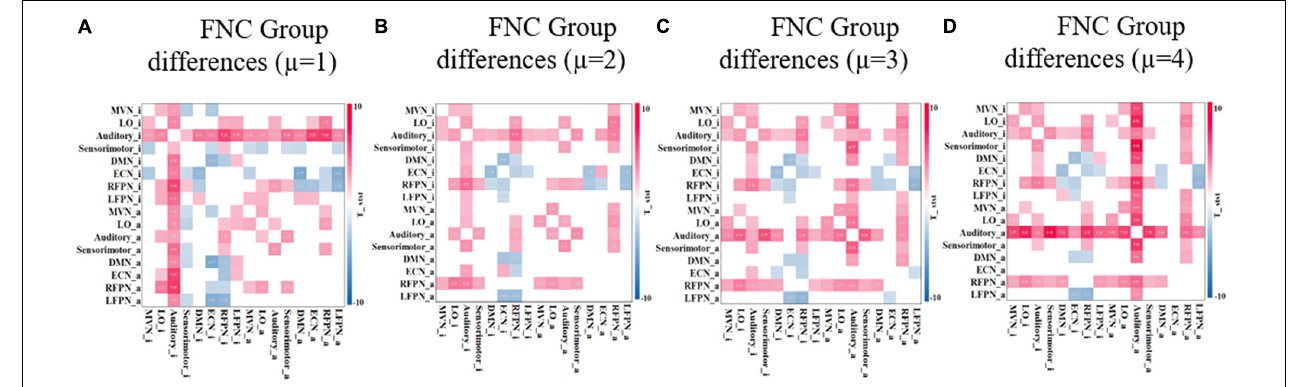
FIGURE 9 | FNC with significant difference between ADHD and HC groups under different threshold µ . (A–D) Different thresholds and the two-sample t -test p < 0.05 (FDR corrected). Red represents that the functional connectivity of ADHD is stronger than that of HC, and blue represents that the functional connectivity of ADHD is weaker than that of HC. FNC, functional network connectivity; ADHD, attention deficit hyperactivity disorder; HC, healthy control; FDR, false discovery rate.